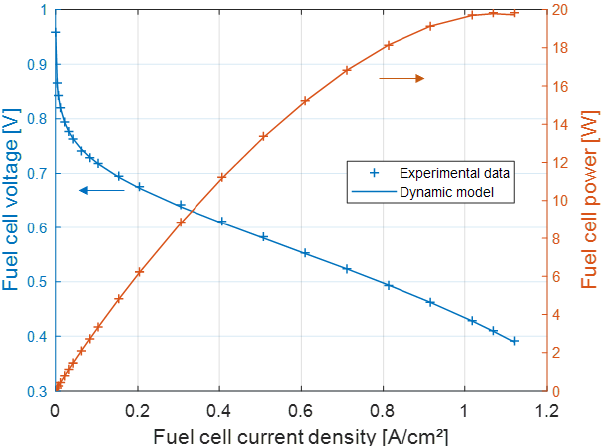
Figure 3. Quasi-static HTPEM fuel cell measured polarization curve.